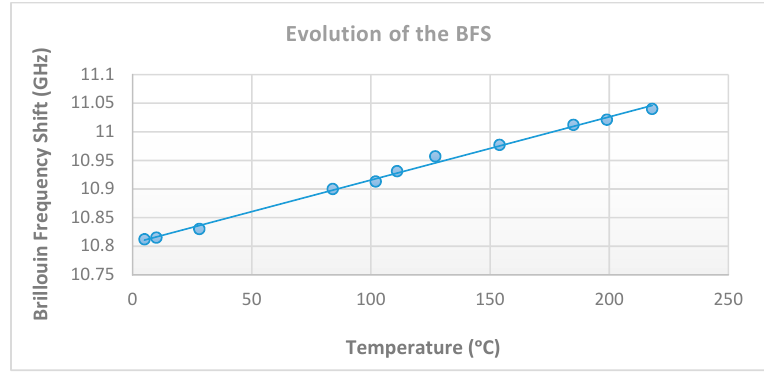
Figure 2. BFS dependence on temperature for the special optical cable used in S. Pedro da Cova.